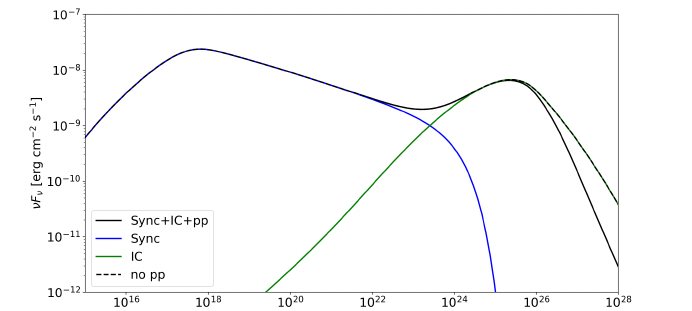
Figure 4. Spectral energy distribution in the GRB afterglow external forward shock scenario estimated with the numerical code presented in this section for t obs = 170 s. The effect of the pair production attenuation is clearly evident in the VHE tail. The set of afterglow parameters used are the following: E k = 1 × 10 53 erg, s = 0, A 0 = 1 cm − 3 , (cid:101) e = 0.2, (cid:101) B = 0.02, Γ 0 = 300, p = 2.5 and z =